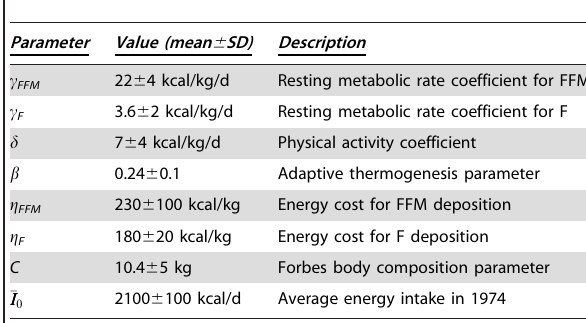
Table 1. Mathematical model